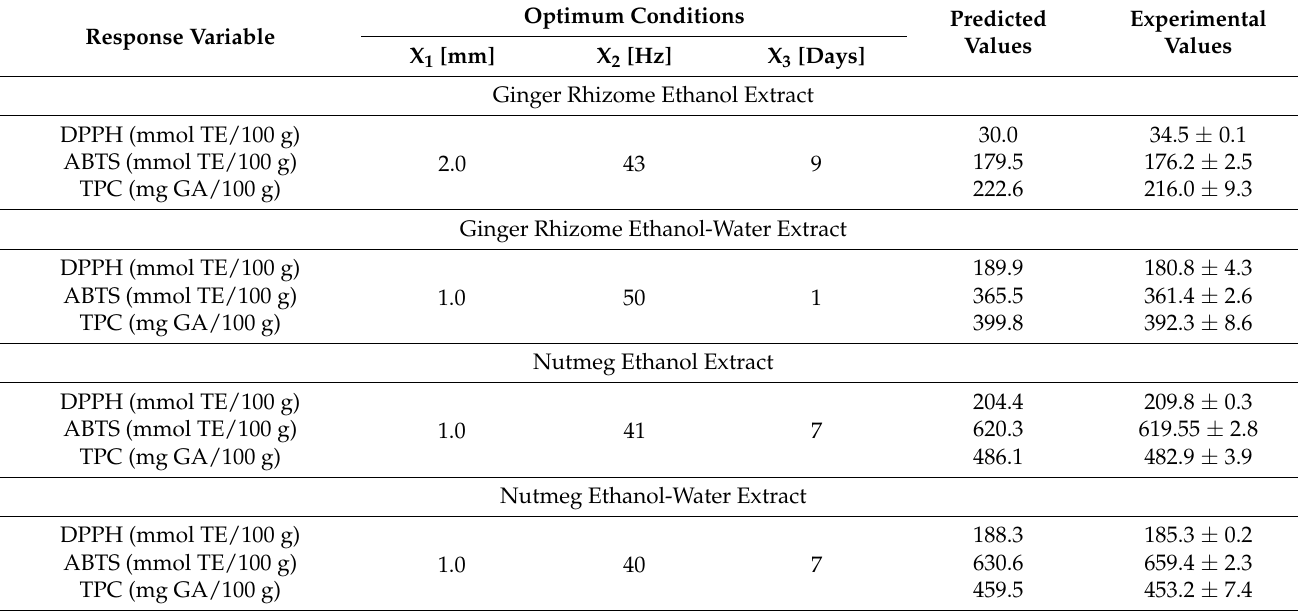
Table 5. Predicted and experimental ( x ± SD ) values of the studied responses for the optimum conditions of spices